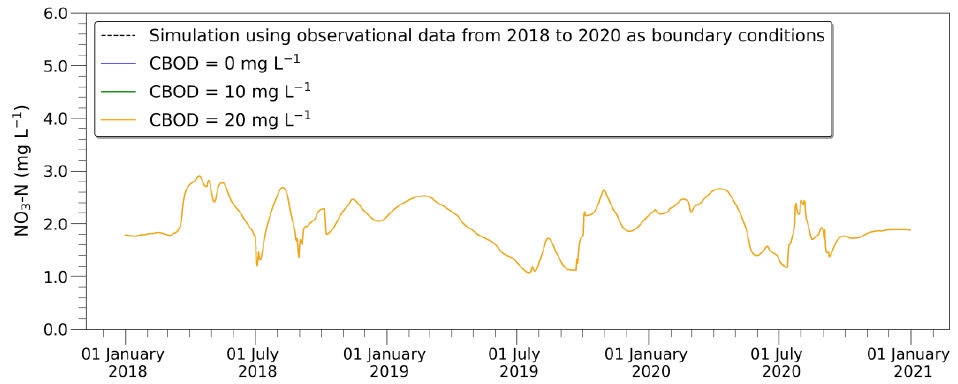
Figure 3. Graph showing the changes in the downstream NO 3 -N concentration caused by changes in the CBOD concentration at all the boundary conditions.